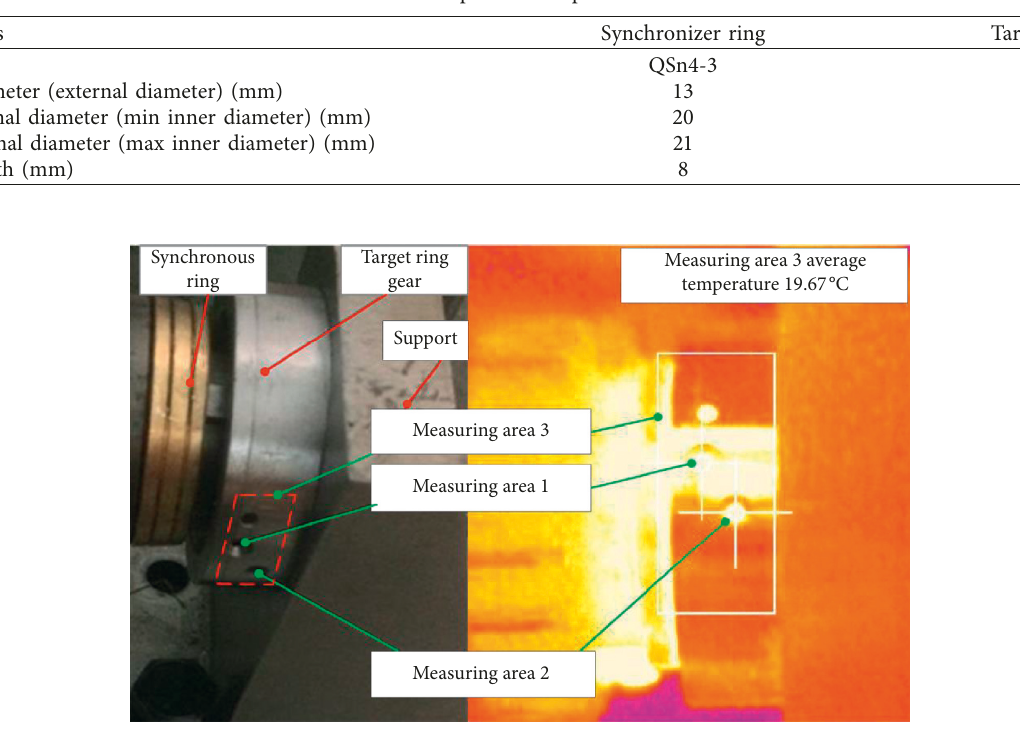
Figure 5: The thermal imagery taken by thermal